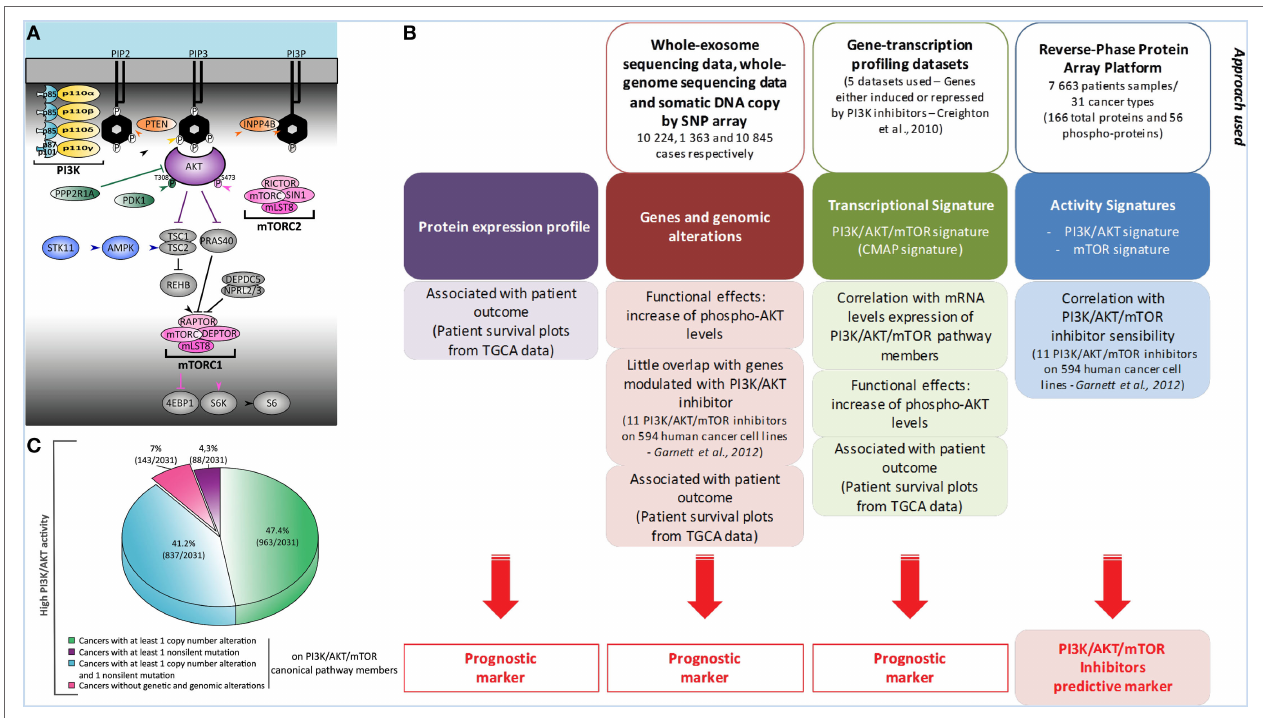
FiGURE 1 | Heterogeneity of phosphatidylinositol-3-kinase (PI3K)/AKT/mammalian target of rapamycin (mTOR) activation in cancer: global and comprehensive mapping by a multiscale integrated approach. (A) Representation of PI3K/AKT/mTOR canonic members. Most omics results use data obtained under treatment with pan-PI3K inhibitors which still display relative isoform specificity, or with PI3K α -selective inhibitors associated with genetic alterations. Usually, only the expression of PIK3CA and PIK3CB is studied. Production of PIP 3 at the plasma membrane is, however, performed by four enzymes: PI3K α , PI3K β , PI3K δ , and PI3K γ . They are composed of a regulatory subunit (p85 or p101/p87) and a catalytic subunit (p110 α , p110 β , p110 δ , or p110 γ ). (B) This schematic summarizes the bioinformatic meta-analysis performed in the study by Zhang et al. (2) using two PI3K/AKT/mTOR transcriptional signatures of Creighton et al. and Garnett et al. (3, 4). (C) Representation of the molecular alterations found in cancer patients with high PI3K/AKT score. Molecular alterations in patients with reverse-phase protein array (RPPA) score values ≥ 0.5 are shown. These RPPA scores were normalized to SDs from the median across all